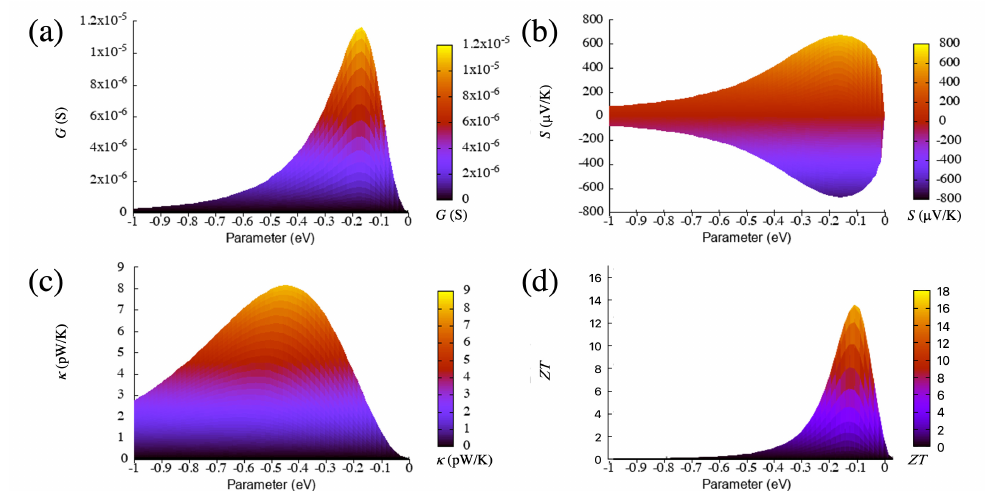
Figure 7. Electrical conductance ( a ), Seebeck coefficient ( b ), electronic thermal conductance ( c ) and figure of merit ( d ) as a function of the coupling parameter for the wedge–wedge configuration (side view of Figure 6). The temperature is 300